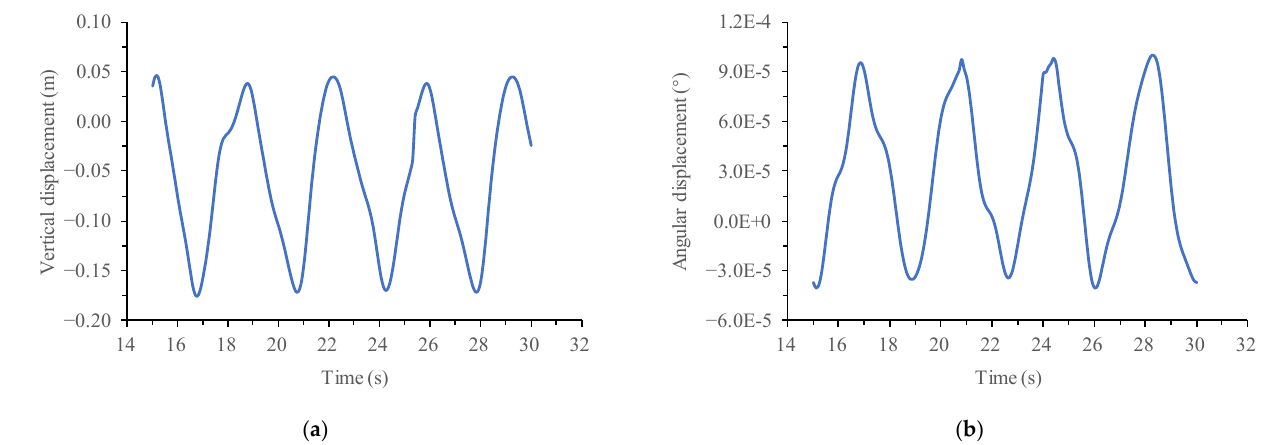
Figure 11. Time ‐ history curve of mid ‐ span displacement of Xiangshan Harbor Bridge when wind speed was 64 m/s. ( a ) Vertical displacement; ( b ) Angular displacement.